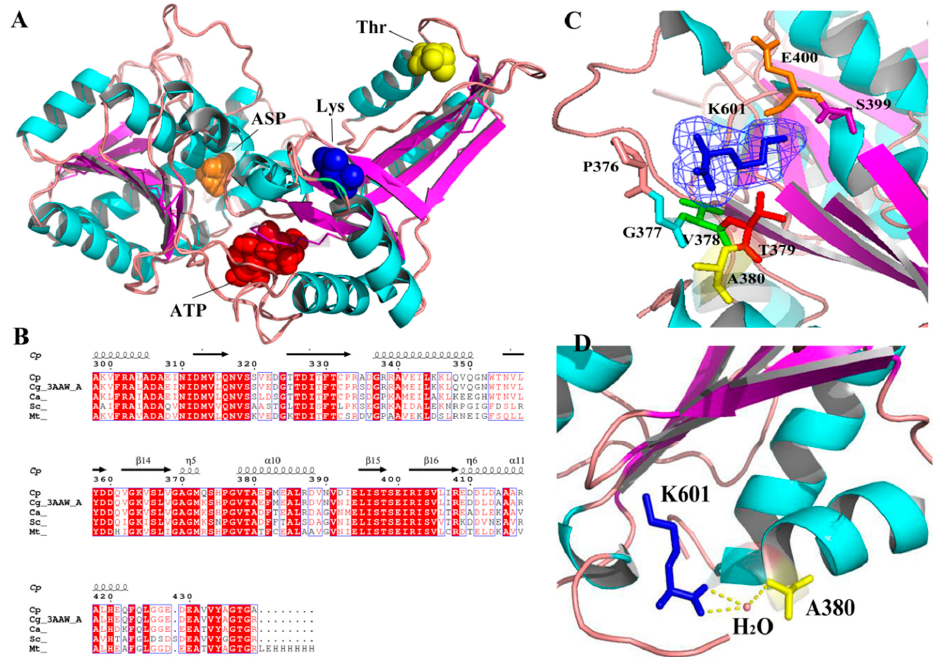
Figure 1. Position of site 380 in the model. ( A ) The novel monomeric model of AK and the docking position of Asp, ATP, Lys and Thr. ( B ) Homologous alignment generated by MEGA6 and modified by ESPript. ( C ) The residue around the binding site of the inhibitor Lys (at site 601 and shown in blue mesh). ( D ) Site 380 with the inhibitor. Blue: inhibitor lysine Yellow: site 380. Site 380 is connected to the inhibitor Lys by a water